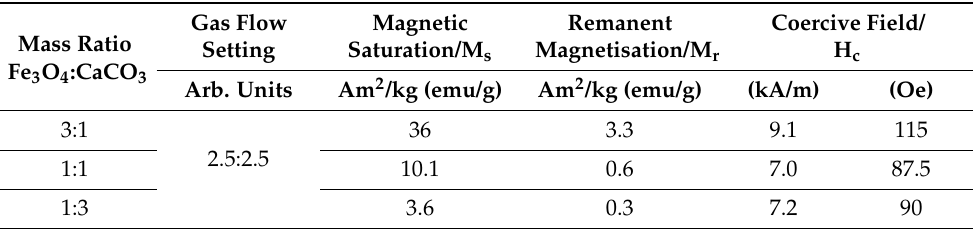
Table 2. Magnetic measurements of flame-spheroidised products as a function of precursor to Figure 3. Magnetisation curves for fl ame-spheroidised Fe 3 O 4 :CaCO 3 (mass ratios 3:1, 1:1 and 1:3; porogen mass ratio. GFS 2.5:2.5) at 26.85 °C. Inset fi gure provides evidence of remanent magnetisation in all cases. Table 2. Magnetic measurements of fl ame-spheroidised products as a function of precursor to poro- gen mass ratio.